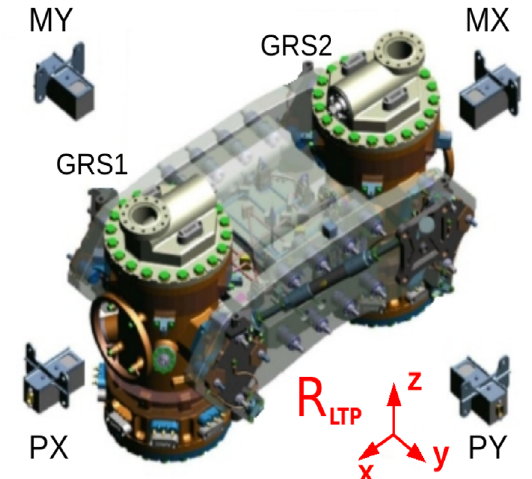
Figure 1. Sketch of the position of the four 3-axis magnetometers placed on board LPF (MX, MY, PX, and PY) with respect to the gravitational reference sensors (GRS1 and GRS2) enclosing the two LPF TMs. The magnetometers were arranged in a cross-shaped con fi guration. MX and PX were placed at the edges of the arm, joining the TM centers ( x direction) where the negative (M) and the positive (P) sides are meant with respect to the middle point between the two GRSs, respectively. Similarly, MY and PY were placed at the edges of the second arm ( y direction), where M and P have the same meaning as the x -axis. The z -axis was chosen to complete the right- handed tern of the LTP reference frame, R LTP .